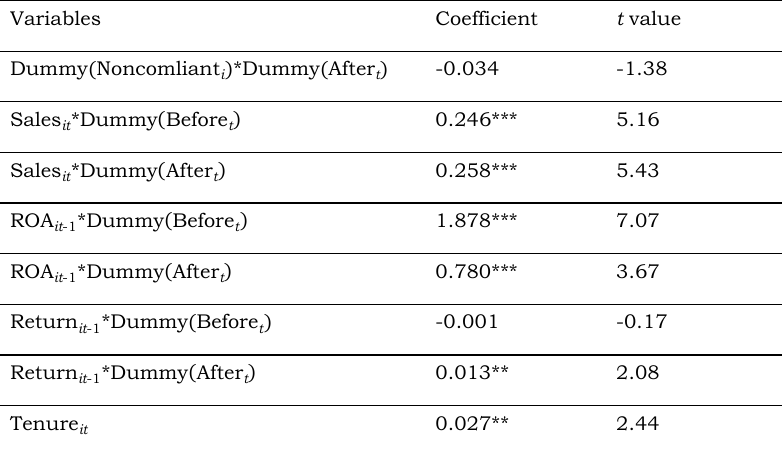
Table 2. Empirical result